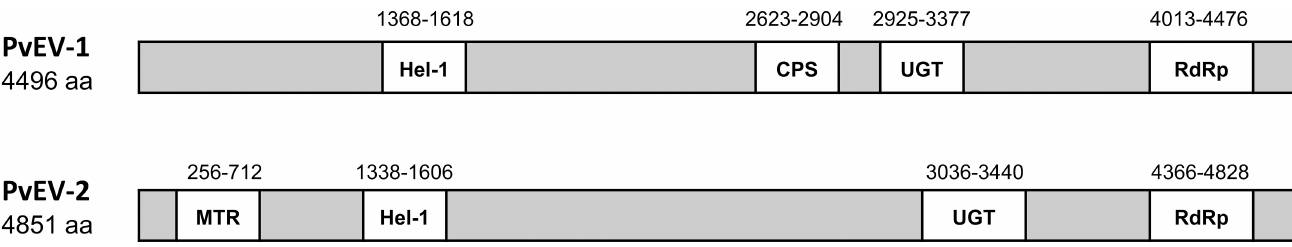
Fig 2. Conserveddomains in the polyprotein encoded by PvEV-1 and PvEV-2 from Nicaragua. Numbers indicatethe residuesdefiningthe conserveddomains.Hel-1, helicase;CPS, putative capsular polysaccharide synthase; UGT, UDP-glycosyltransferase; RdRp, RNA-dependant RNA polymerase; and MTR,